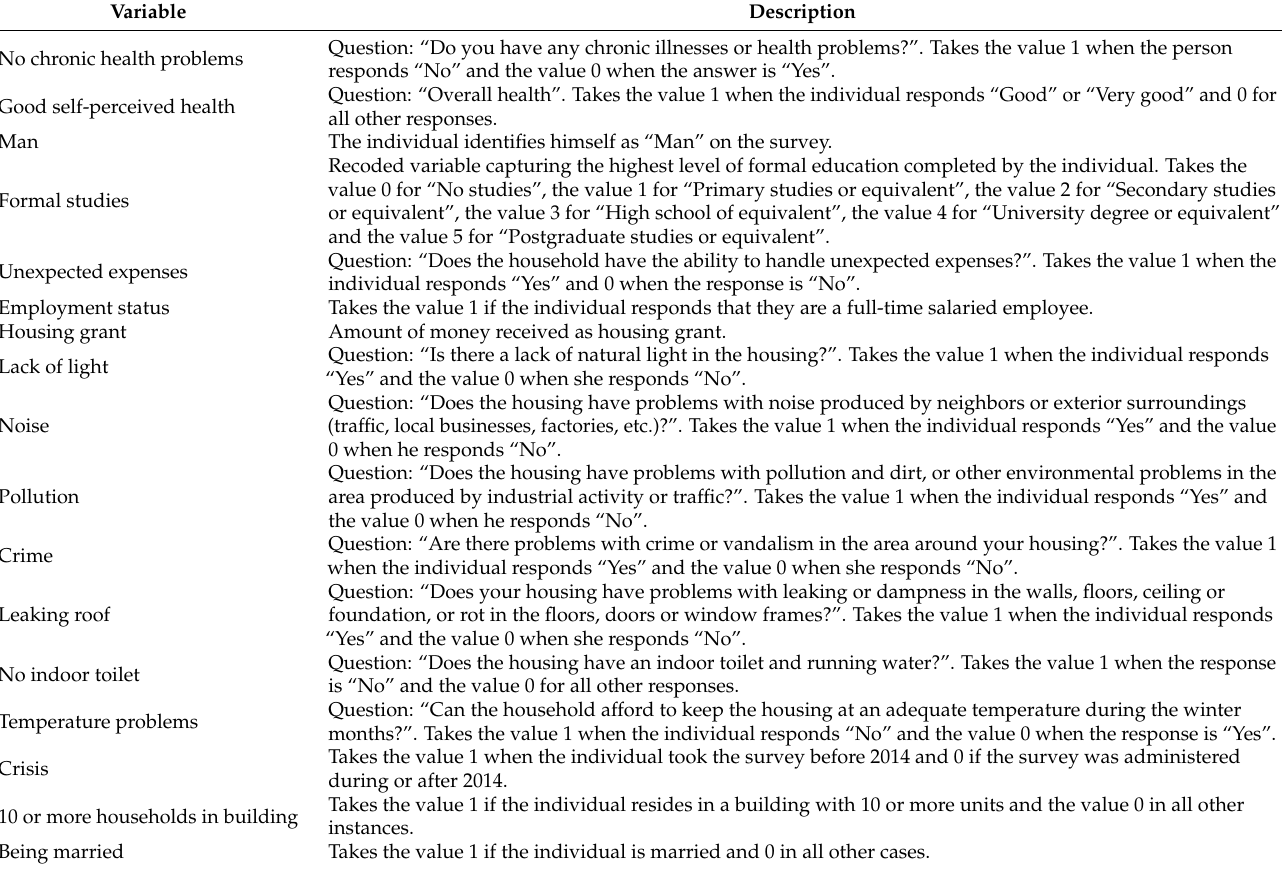
Table A1. Specification of individual